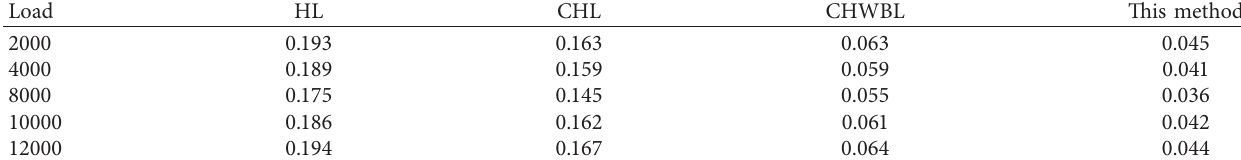
Table 1: Comparison of load balancing degree of different strategies in the central network environment.